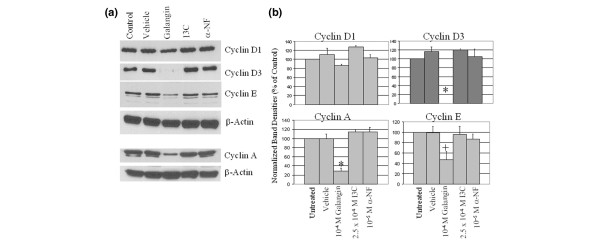
Galangin down-regulates expression of cyclins D3, A, and E. Hs578T cells were left untreated or were treated with vehicle, 10-4 M galangin, 2.5 × 10-4 M indole 3-carbinol (I3C), or 10-5 M α-naphthoflavone (α-NF) and assayed for cyclin D1, D3, E, and A expression 18 hours thereafter by western blotting. Blots were stripped and reprobed with β-actin-specific antibody to control for sample loading. (a) Data from one representative experiment from a total of three experiments are presented. (b) Cyclin band densities were normalized with β-actin band densities and then expressed as a percentage of β-actin normalized cyclin expression in untreated cultures. Data are pooled from three experiments and expressed as the percent of control of the respective normalized band densities + standard errors. An asterisk (*) indicates a significant decrease in cyclin expression relative to vehicle controls, p < 0.001. A cross (+) indicates a significant decrease, p < 0.02.